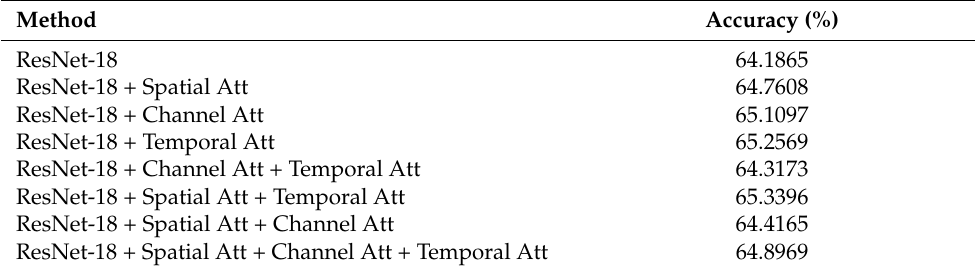
Table 6. Comparison of various combinations of attention